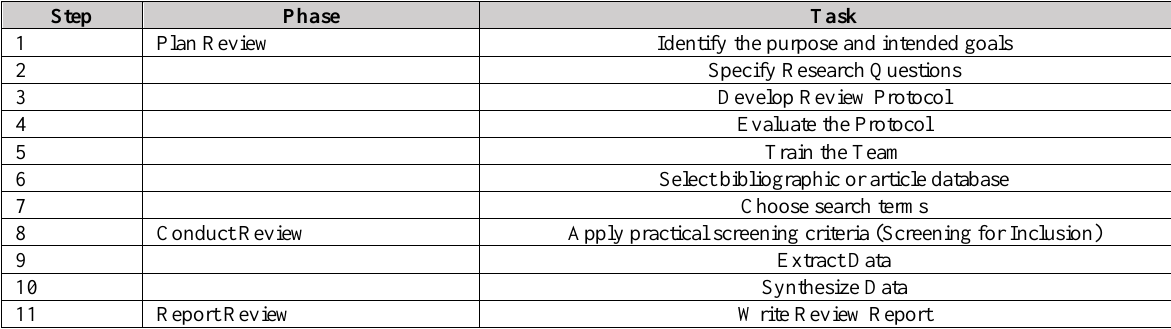
Table 3. Systematic Literature Review